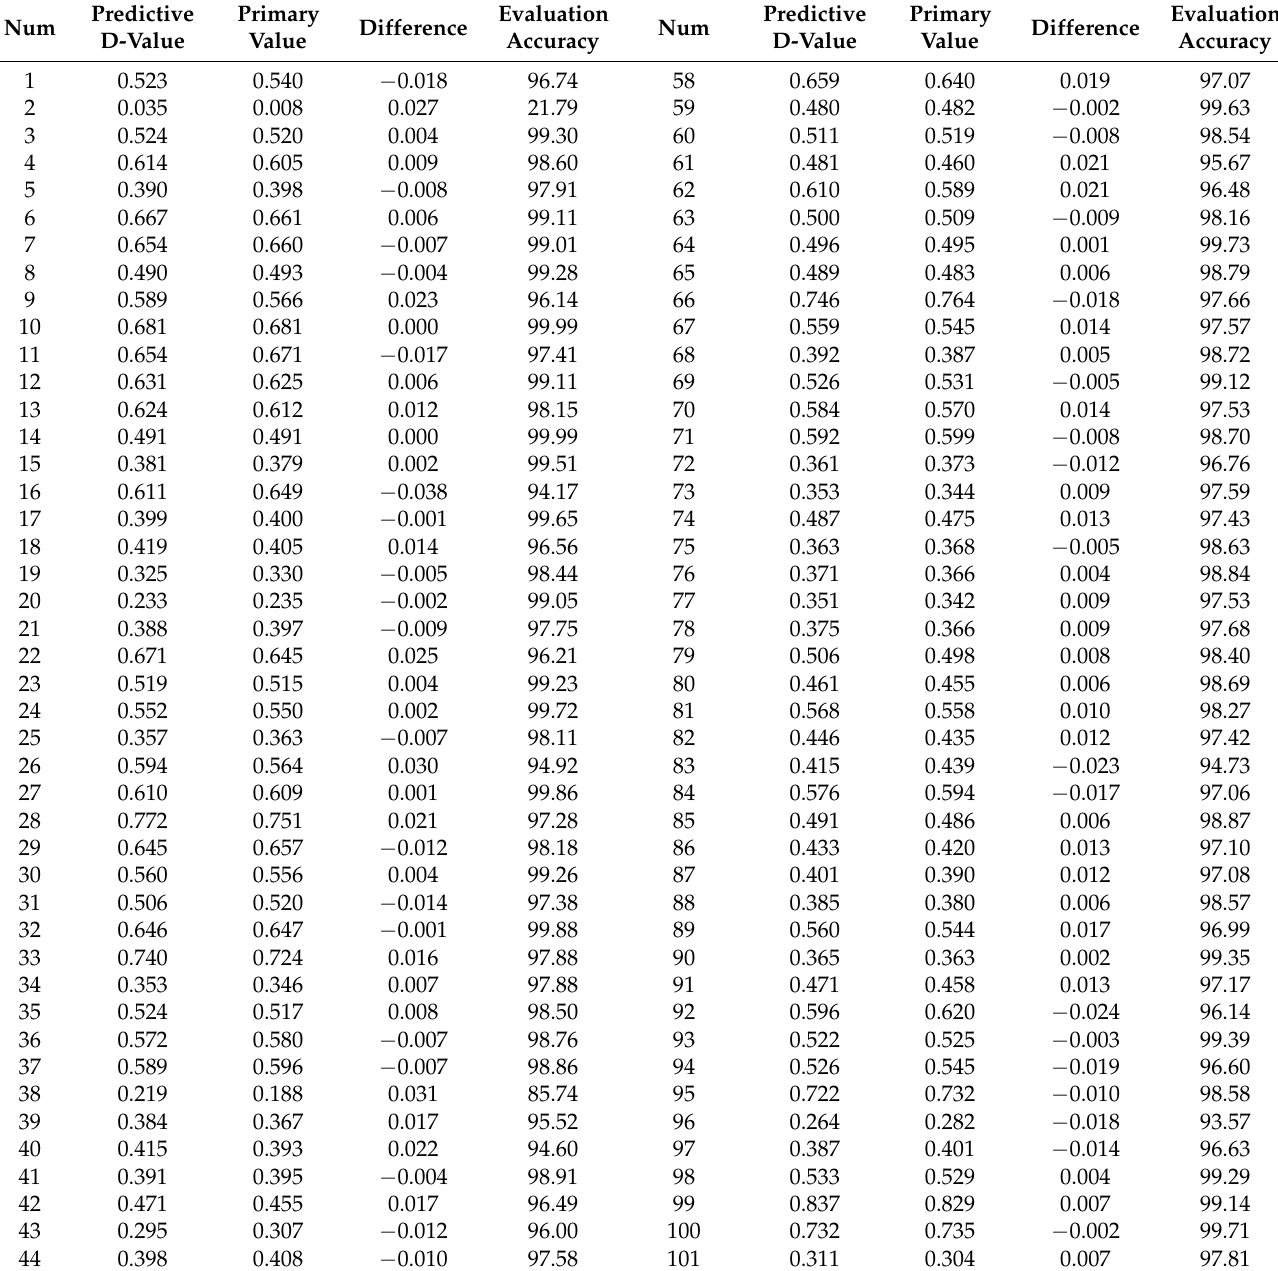
Table 3. Analysis of evaluation accuracy of the